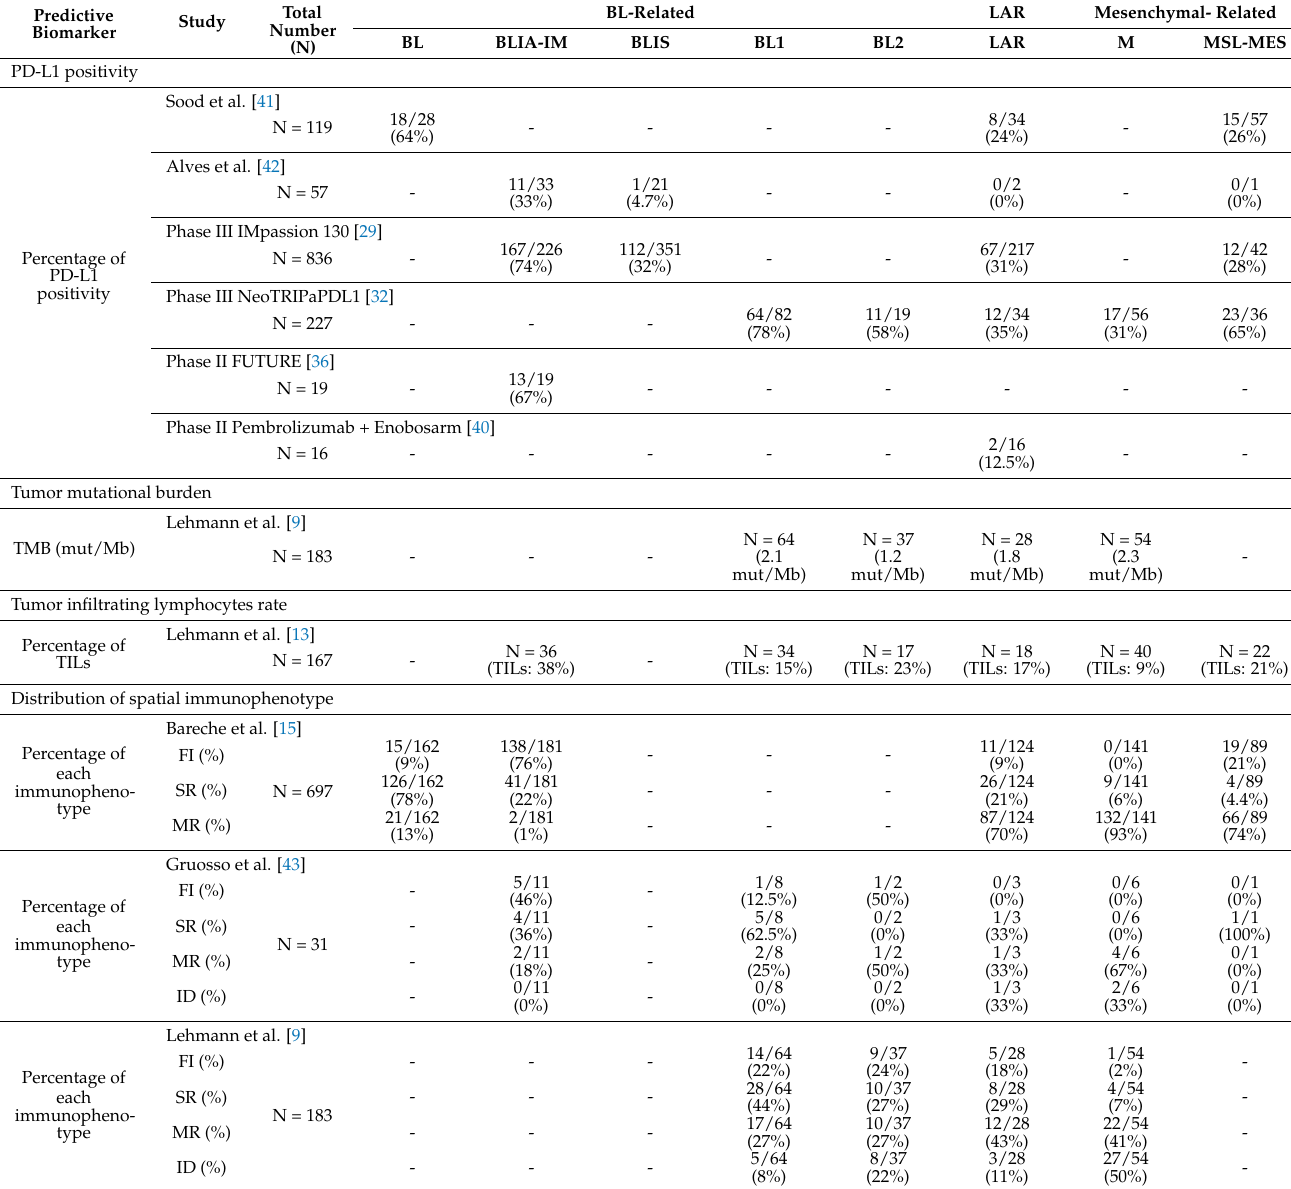
Table 2. Distribution of biomarkers across different TNBC molecular